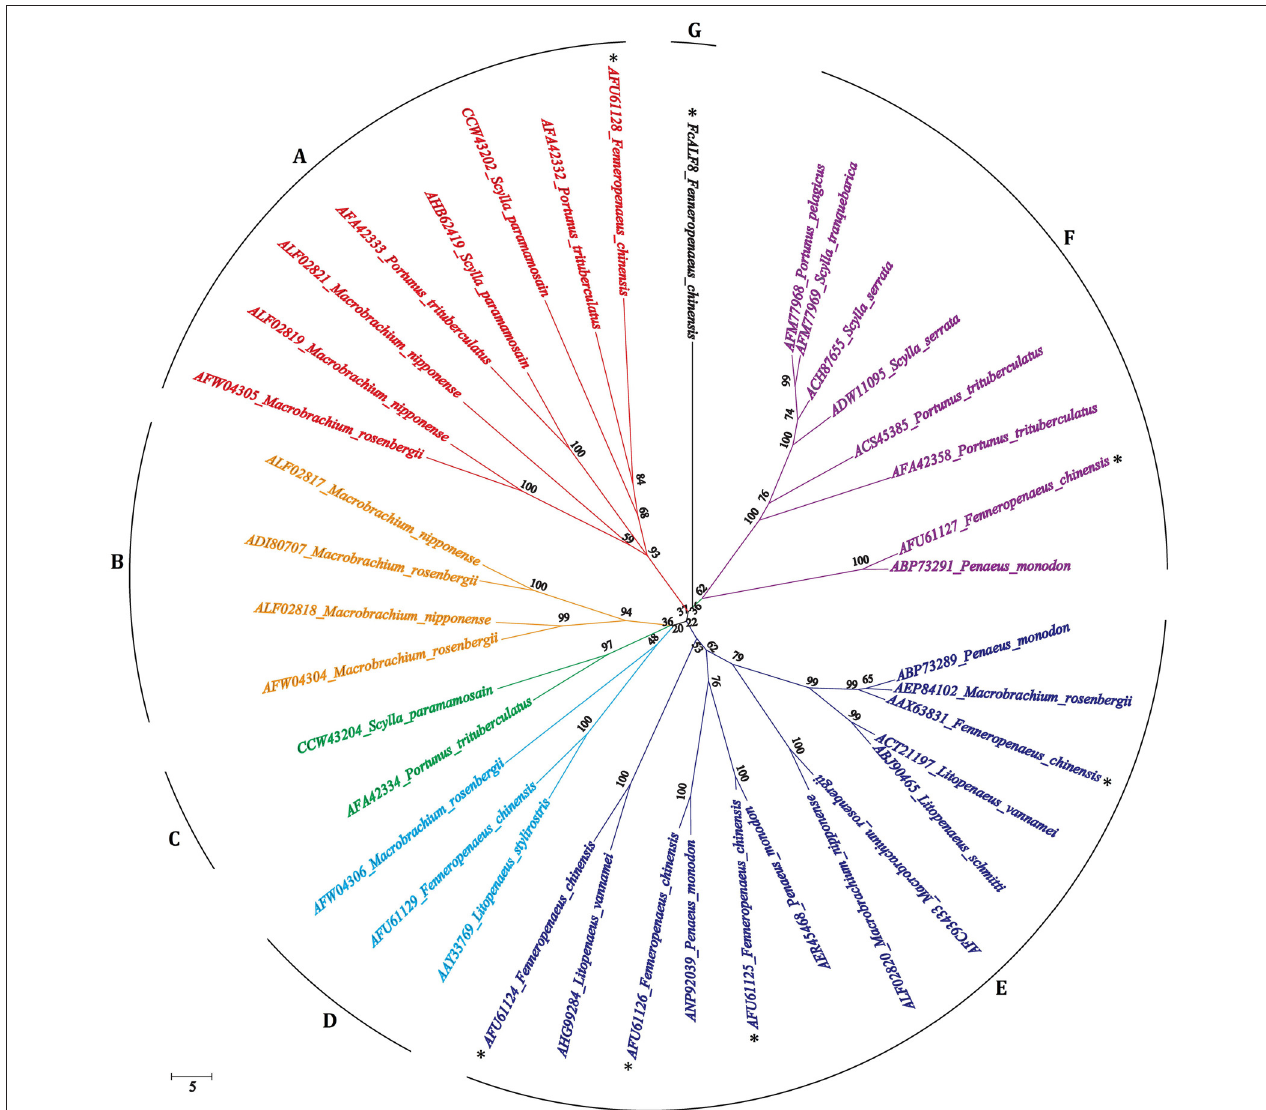
FIGURE 2 | Bootstrapping phylogenetic analyses of anti-lipopolysaccharide factors (ALFs) from twelve crustacean species. The ALFs were showed with GenBank accession numbers listed in Table 2 . Whole deduced amino acid sequences excluding signal peptide of ALFs were used for phylogenic analysis by Neighbor-Joining. Bootstrap value was set at 1,000. Percentage of bootstrap replications and divergence distance were shown in the figure. The branches of different type ALFs (with < 40% of bootstrap replications) were shown with different colors and capital letters (A–G) . ALF sequences from F. chinensis were marked with a star (*).